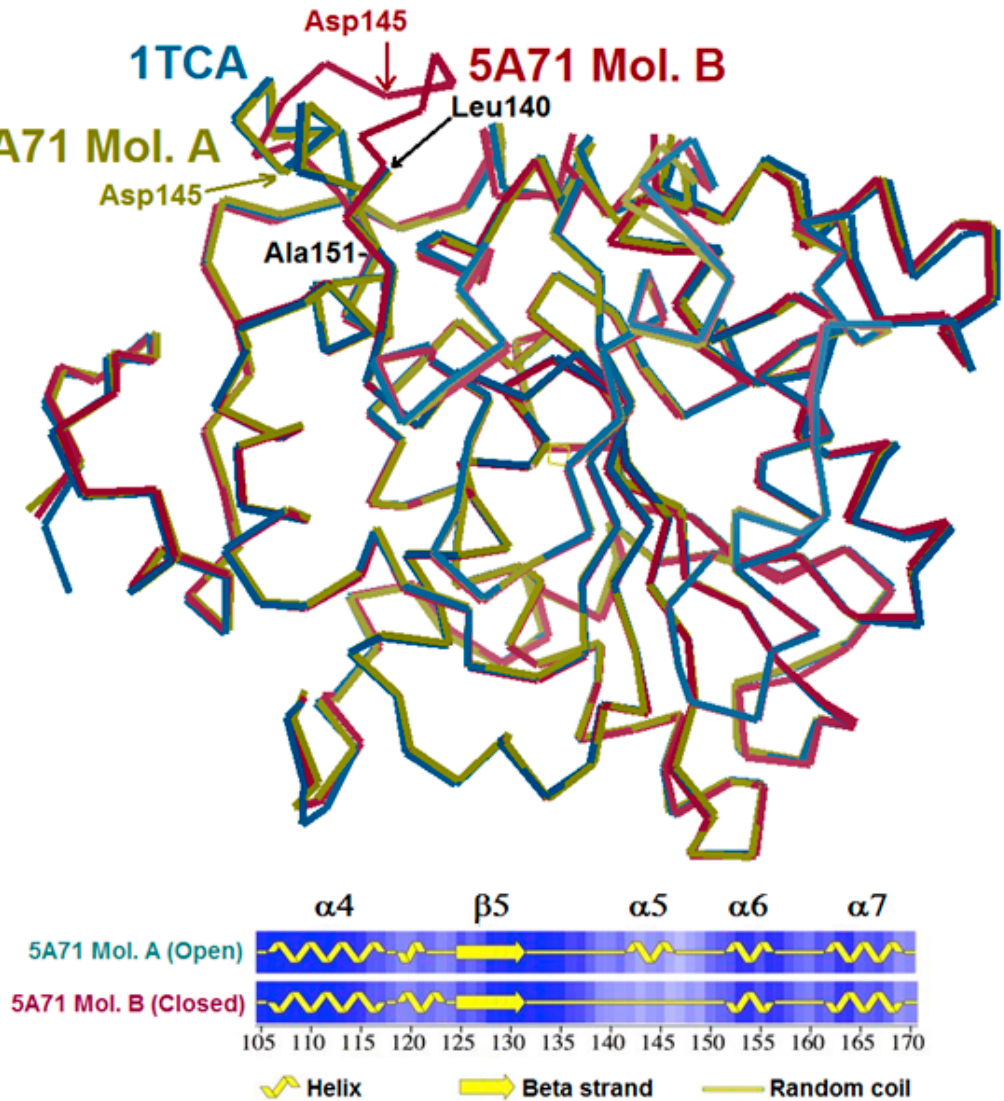
Figure 4. Superposition of the CAL-B structure 1TCA [27] and two monomers A and B of the CAL-B structure 5A71 [30]. In 5A71 monomer A (green), an α -helix 5, which involves residues Leu140-Leu147, has a similar ’classical’ open conformation, like in the 1TCA (blue) structure. The 5A71-A molecule superimposes with 1TCA with an RMSD value of 0.58. The residue range 140–151, in monomer B of 5A71 (red) undergoes dramatic conformational change and becomes an unfolded loop. The RMSD value of superimposed monomers A and B of 5A71 is equal to 1.41 [30]. The Figure was created using Coot software [39].